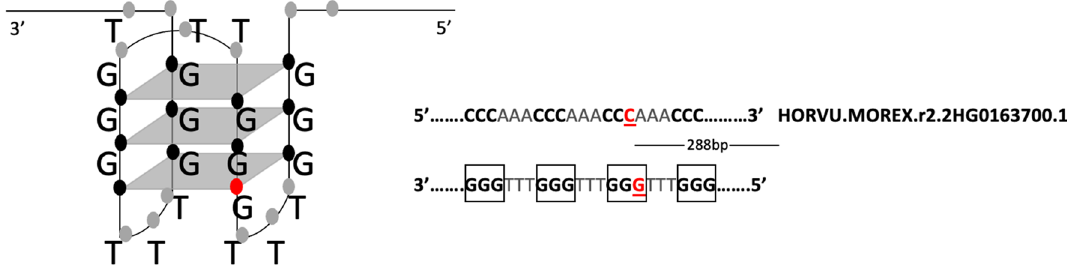
Figure 7. A representation of the localization of SNPs disruptive to G4 structure formation. On the left, the G4 structure is shown with a variation. Red dot indicates changes to the conformation of the bottom G-quartet, black dots indicate possible sites prone to conformation change, and gray dots indicate sites with less influence on G4 structure formation. On the right, the same motif sequence is shown on a linear plane on the sense and the antisense strands. G-stems were indicated as bold within the box. Mutation site is underlined. The distance of the variation to the closest gene is